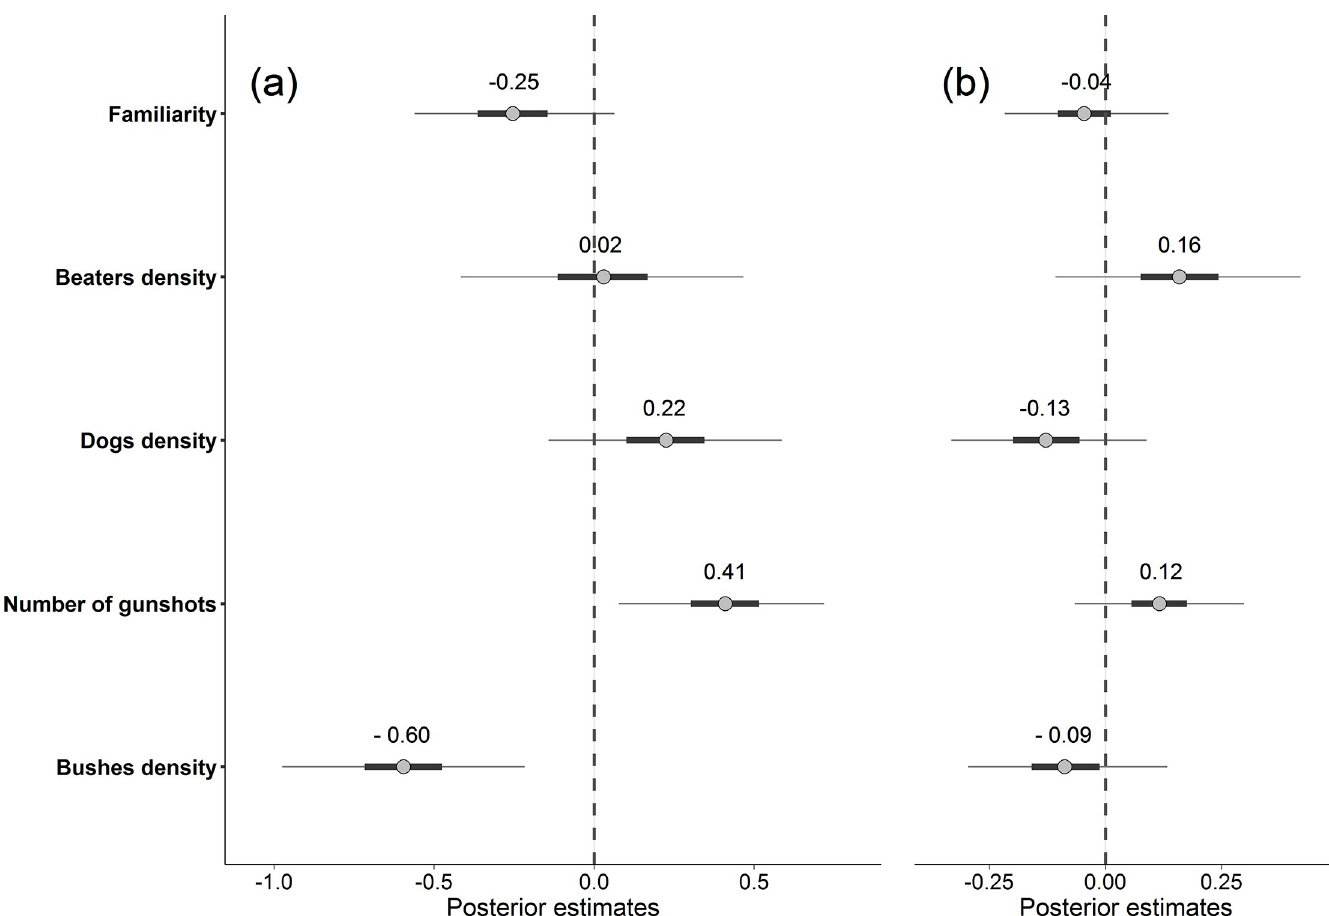
Fig 4. Estimates of the effects of site familiarity, beater density, dog density, number of gunshots during the drive hunt and understorey density within the hunted area on the distance covered by red deer (a) during the drive hunt and (b) over the 12 hour period following a drive hunt in the National Estate of Chambord, France, 2016–2018. Grey dots represent posterior medians. Error bars show 95% credible intervals. Error bars identified by the thicker line show 75% credible intervals. Each tested variable had a significant effect on the immediate phase of red deer movement responses when the 95% credible intervals (dashed lines) did not overlap